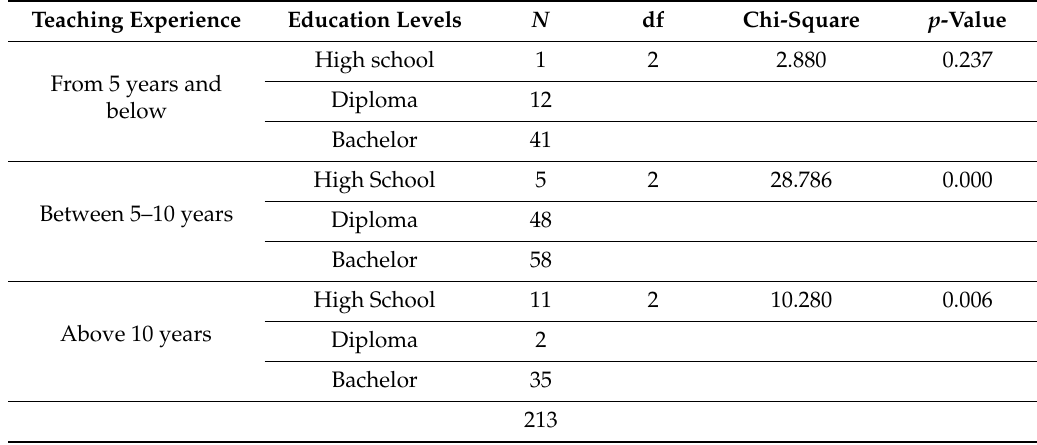
Table 10. Kruskal–Wallis Test for social belief (teaching experiences and education